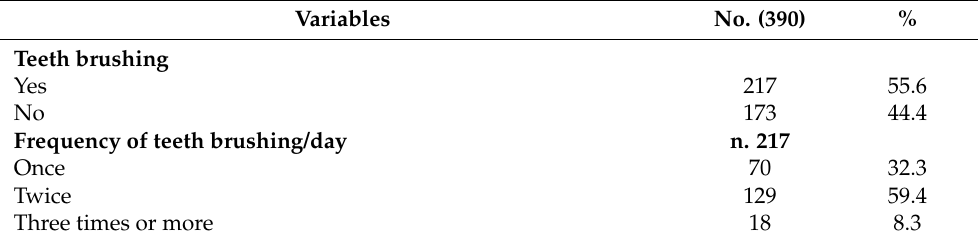
Table 2. Older adults’ oral health care practices, perception, dental visit satisfaction, and